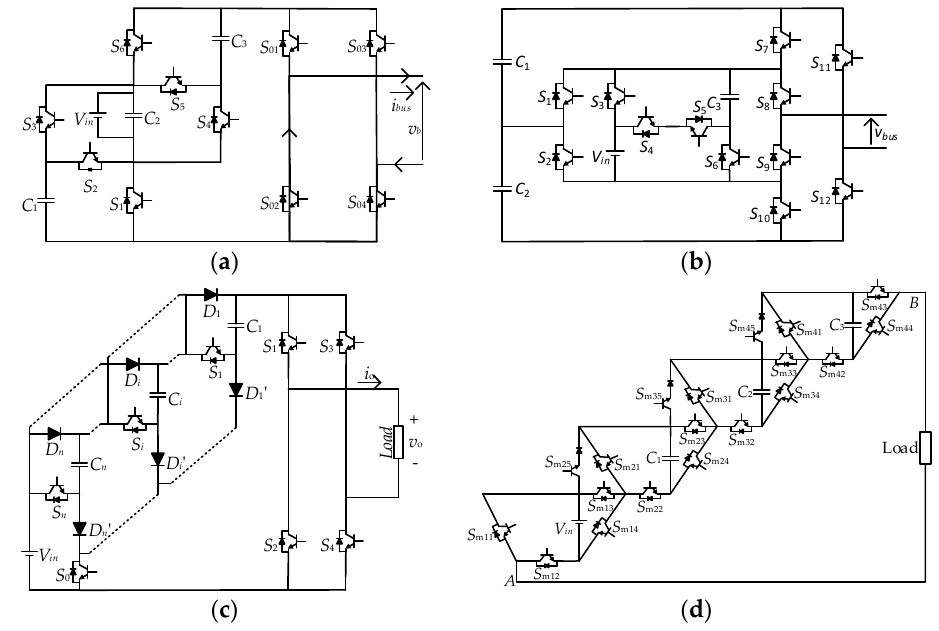
Figure 2. The inverters proposed in open literatures. ( a ) The inverter proposed in [15]. ( b ) The inverter proposed in [24]. ( c ) The inverter proposed in [19]. ( d ) The inverter proposed in [26].